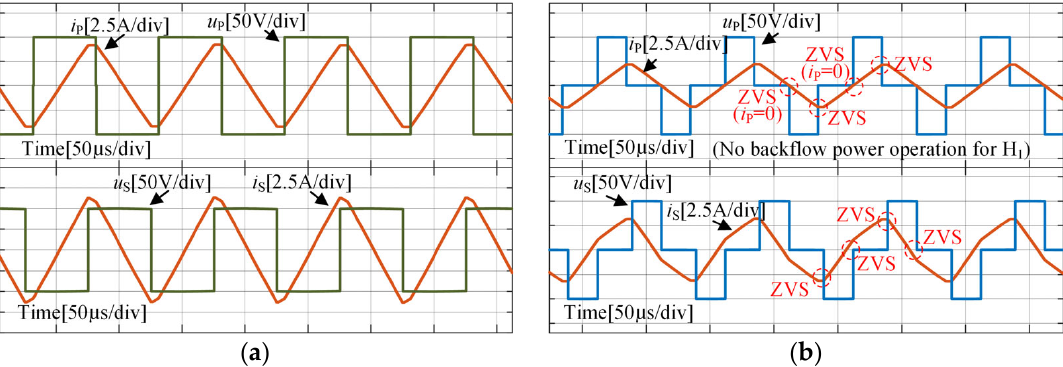
Figure 11. Steady ‐ state waveforms with two control methods in LCL resonant tank when U in = 20 V and k = 0.4. ( a ) SPS modulation; ( b ) Soft ‐ switching and no backflow power control.